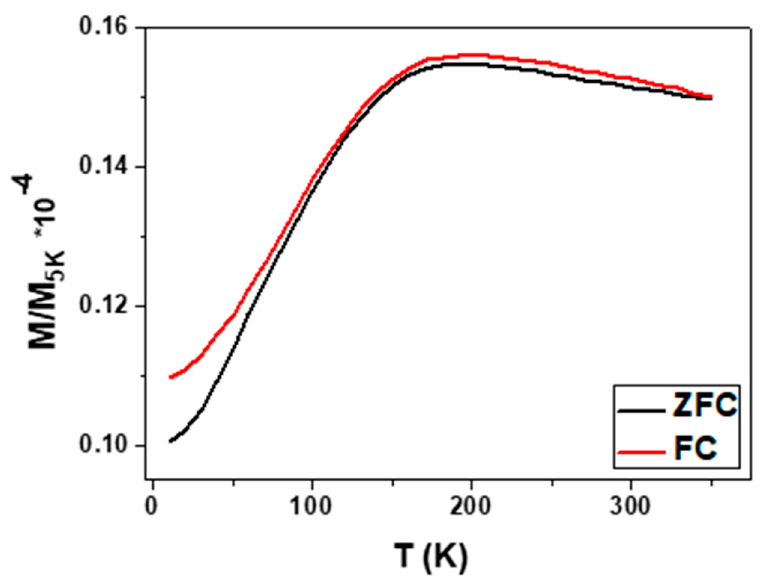
Figure 7. Zero field cooling (ZFC) and field cooling (FC) of as-prepared Co 2 MnSi glass-coated mi- crowires.